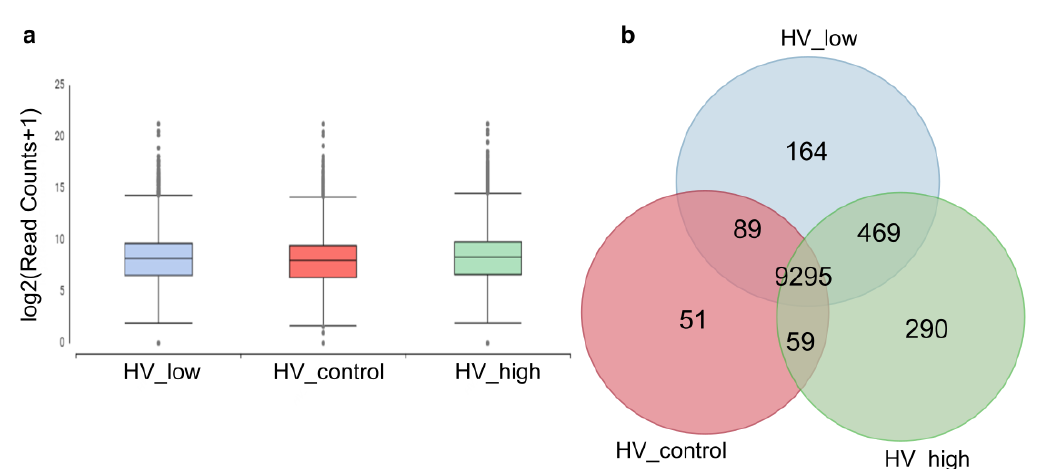
Figure 4. Numerical data of transcripts and their abundancies between the three samples. ( a ) Dis- tribution of read counts of transcripts at the gene level. ( b ) Venn diagram: number of transcripts present in the investigated samples and unigenes. Marks: control (red: HV_control), treated samples with a high and low dosage of ELICE16INDURES (green: HV_high and blue: HV_low).